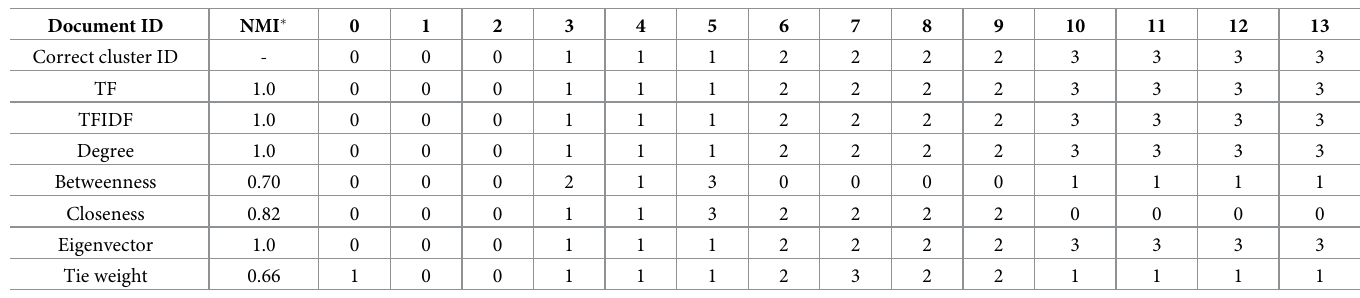
Table 4. Results of the clustering analyses of the 14